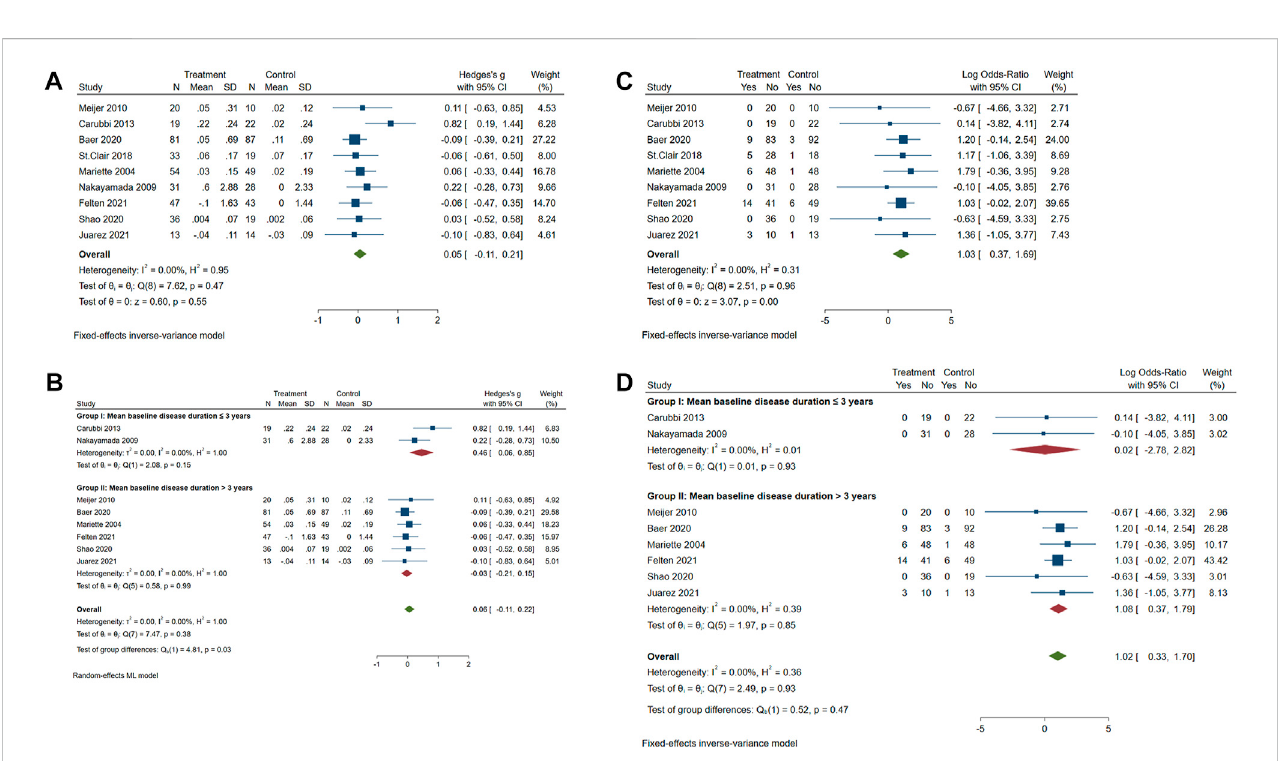
FIGURE 4 Forest plotofstudiescomparingtheinterventionofbiologicsandcontrol groupsonpSSpatients. (A) Changeofthecourseofdisease(UWS). (B) Change ofUWSwhentrialsweresubgroupedbypatientbaselinediseaseduration. (C) Occurrenceofseriousadverseevents(SAEs). (D) OccurrenceofSAEswhentrials were subgrouped by patient baseline disease